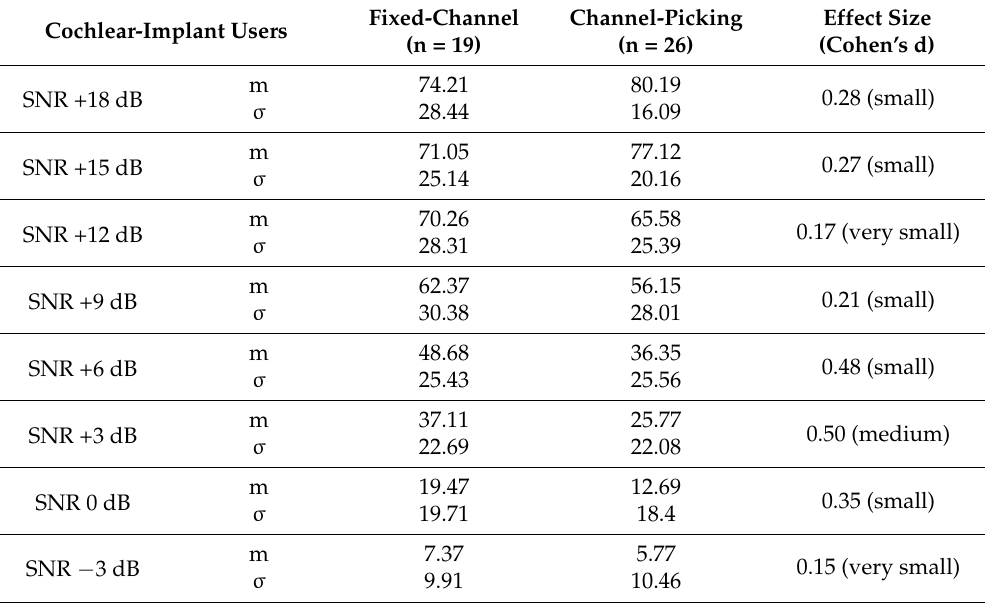
Table 4. Percentage comparisons for cochlear implant users between the coding strategies. Cochlear-Implant Users